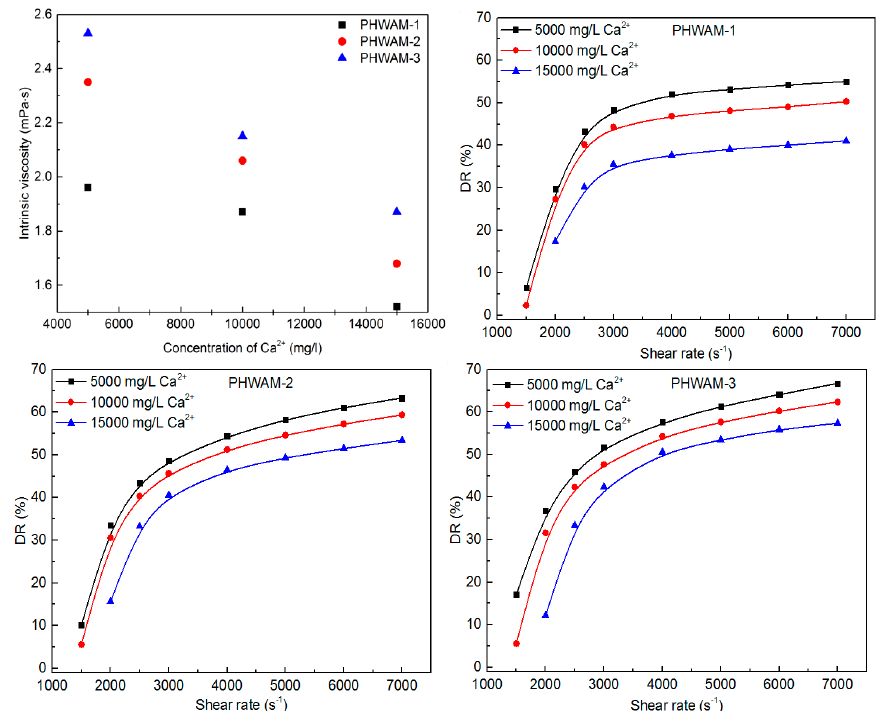
Figure 14. Viscosity and DR performance of 0.15 wt.% drag reducers in brine (10 × 10 4 mg/L) with different Ca 2+ concentrations: 5000 mg/L, 10,000 mg/L, and 15,000 mg/L.